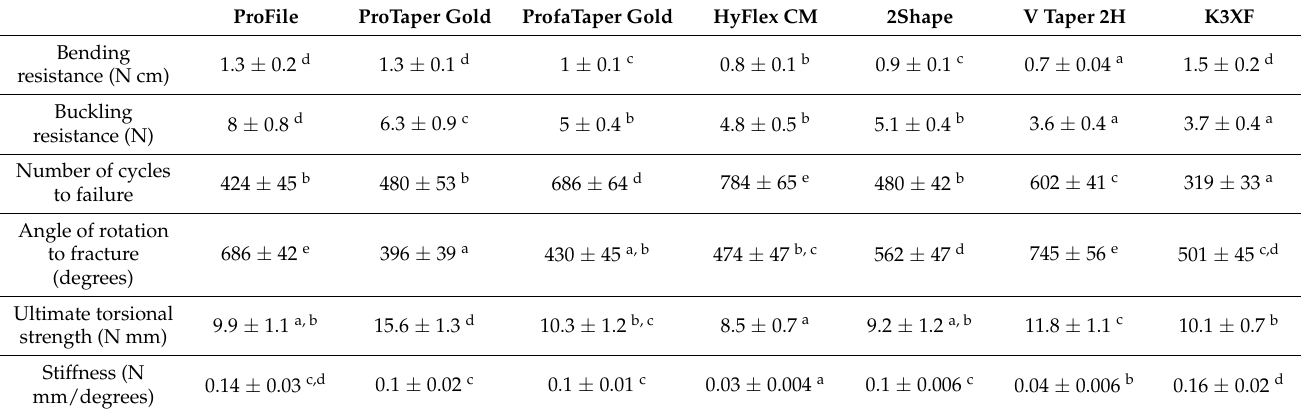
Table 2. Mechanical test results. Mean ± standard deviation.